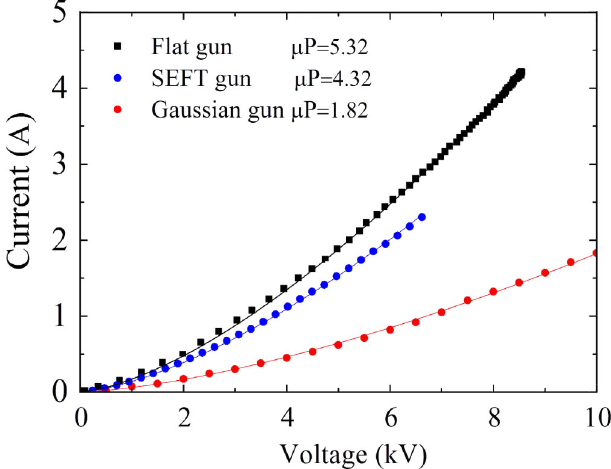
FIG. 10. (Color) Volt-ampere characteristics of the three elec- tron guns, solid lines are fits according to Child’s law P ¼ I=U 3 = 2 a .